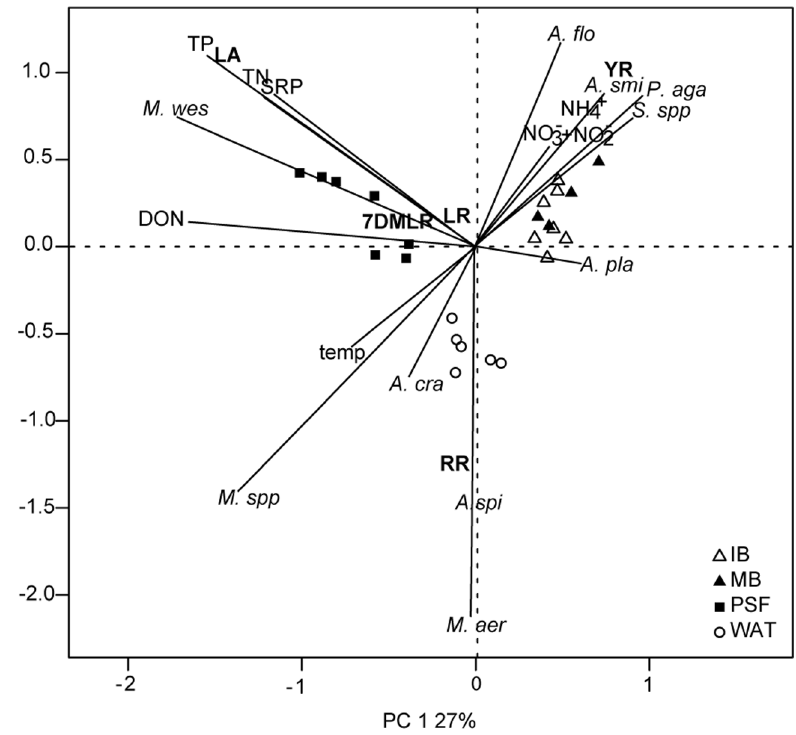
Figure 4. Principal component analysis (PCA) (scaling 1) of environmental variables, cyanobacteria species and MC congeners. The length of a vector is proportional to the importance of the descriptor to the sites. (IB; Bromont integrated epilimnion, MB; Bromont metalimnion, PSF; Petit Lac St. Franc¸ois, WAT; Waterloo). Cyanobacterial species are in italics , MC variants are in bold . A. cra; Anabaena crassa, A. pla; Anabaena planktonica, A. smi; Anabaena smithii, A. spi; Anabaena spiroı¨des, A. flo; Aphanizomenon flos-aquae, M. aer; Microcystis aeruginosa, M. wes; Microcystis wesenbergii, M. spp.; Microcystis spp., P. aga; Planktothrix agardhii, S. spp.; Spirulina spp.